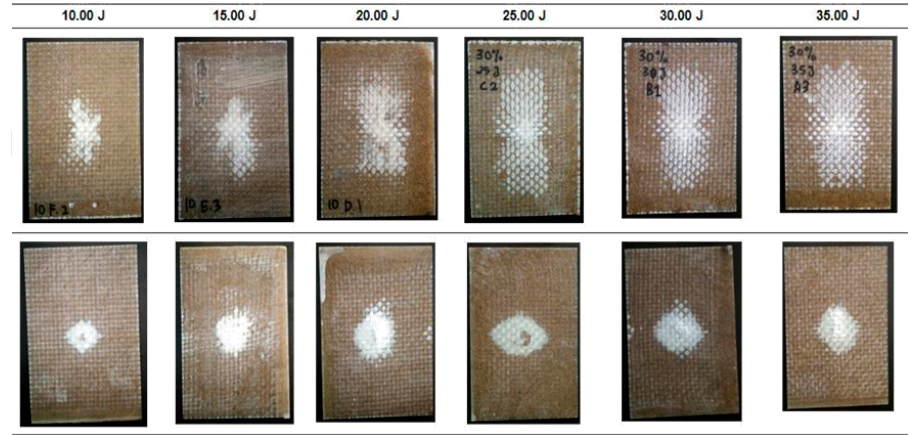
Figure 11. Visible damage on the impacted samples of EP/G-BF10.